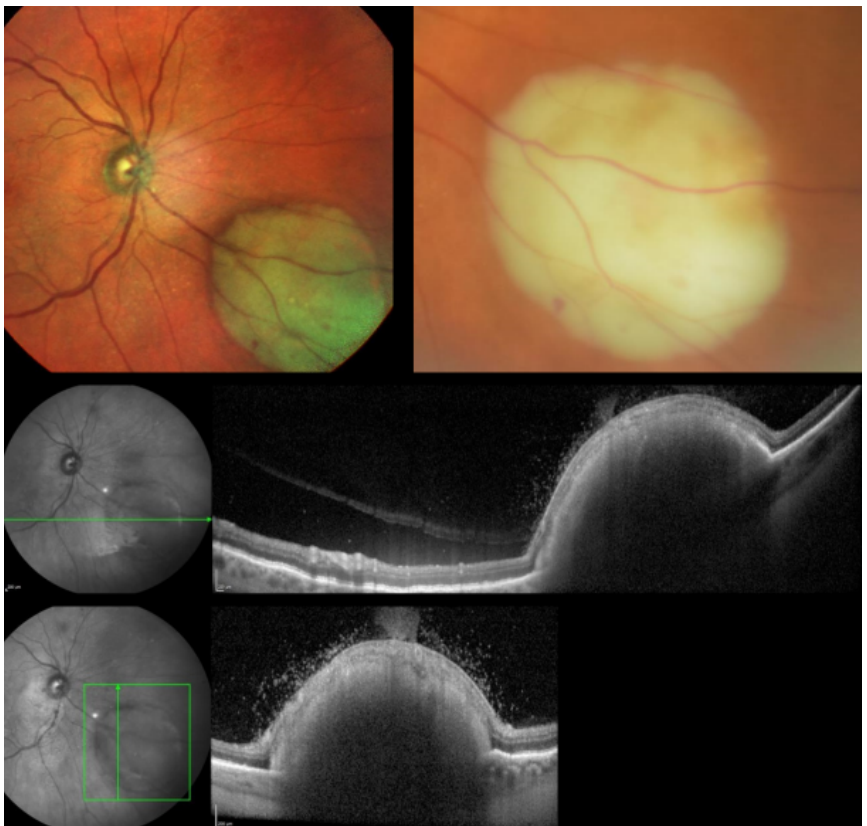
Figure 1: Fundal photographs and OCT scan images showing right subretinal abscesses